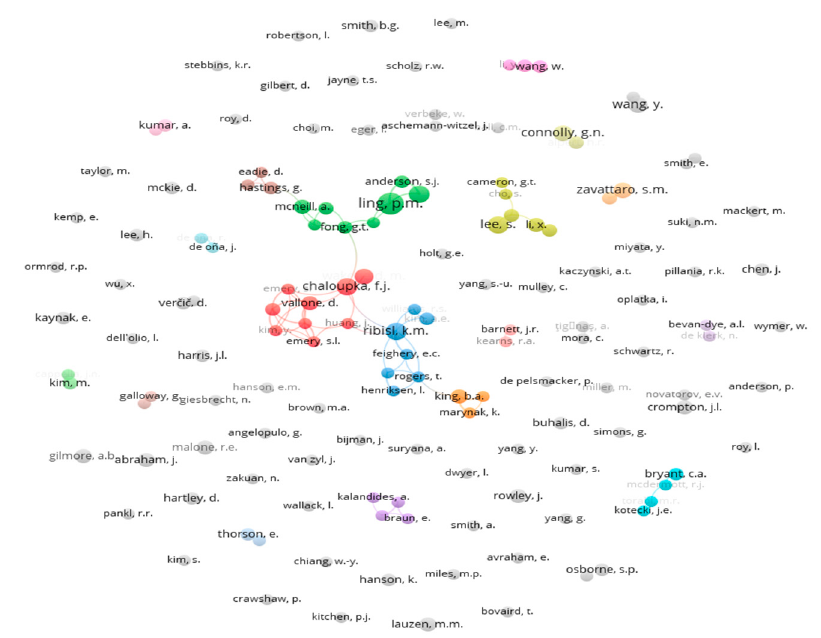
Figure 5. Co-authorship networks, using VOSviewer software.